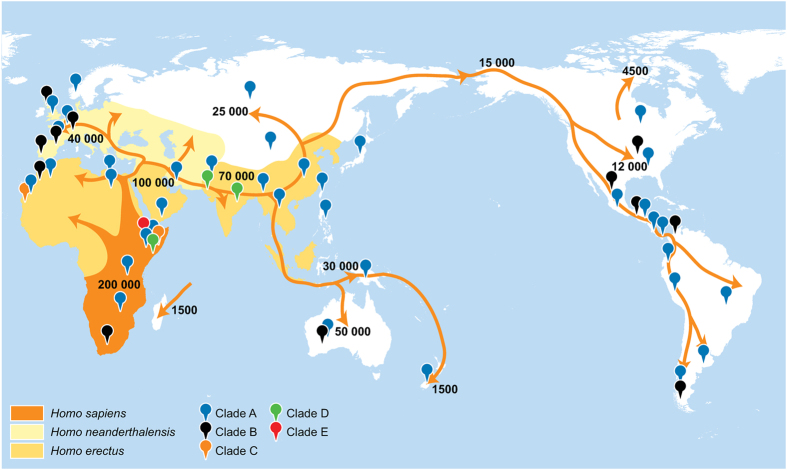
A map of early human migration patterns and the distribution of Pediculus humanus clades.